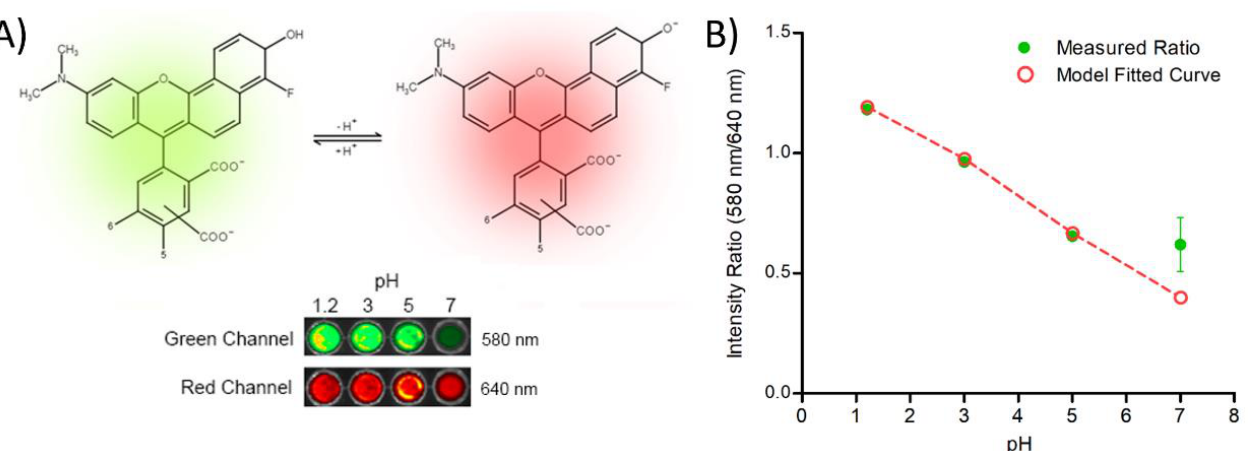
media for 2 h and then pH 6.8 for an additional 22 h containing bromocresol green.